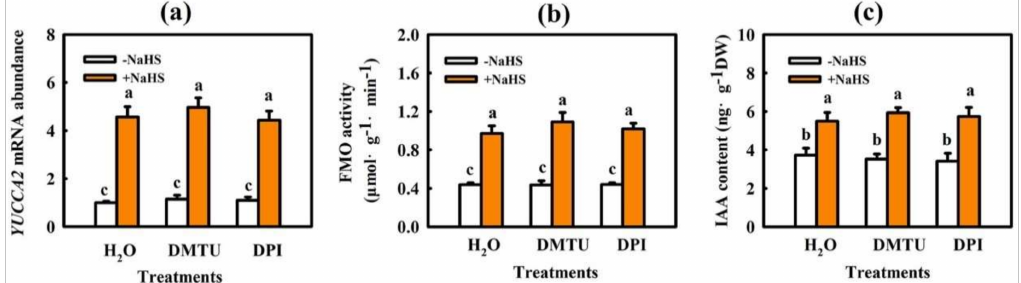
Figure 9. Effect of DMTU and DPI on H 2 S-induced IAA production in cucumber seedlings. ( a ) YUCCA2 mRNA abundance; ( b ) FMO activity; ( c ) IAA accumulation. Cucumber seedlings were pretreated with 5.0 mM DMTU, 100 µ M DPI, or deionized water and then sprayed with NaHS after 6 h. Twelve hours later, the seedlings were exposed to 5 ◦ C for 9 h. The data represent the mean ± SD of three biological replicates. Different letters indicate significant differences ( p < 0.05), according to Duncan’s new multiple range